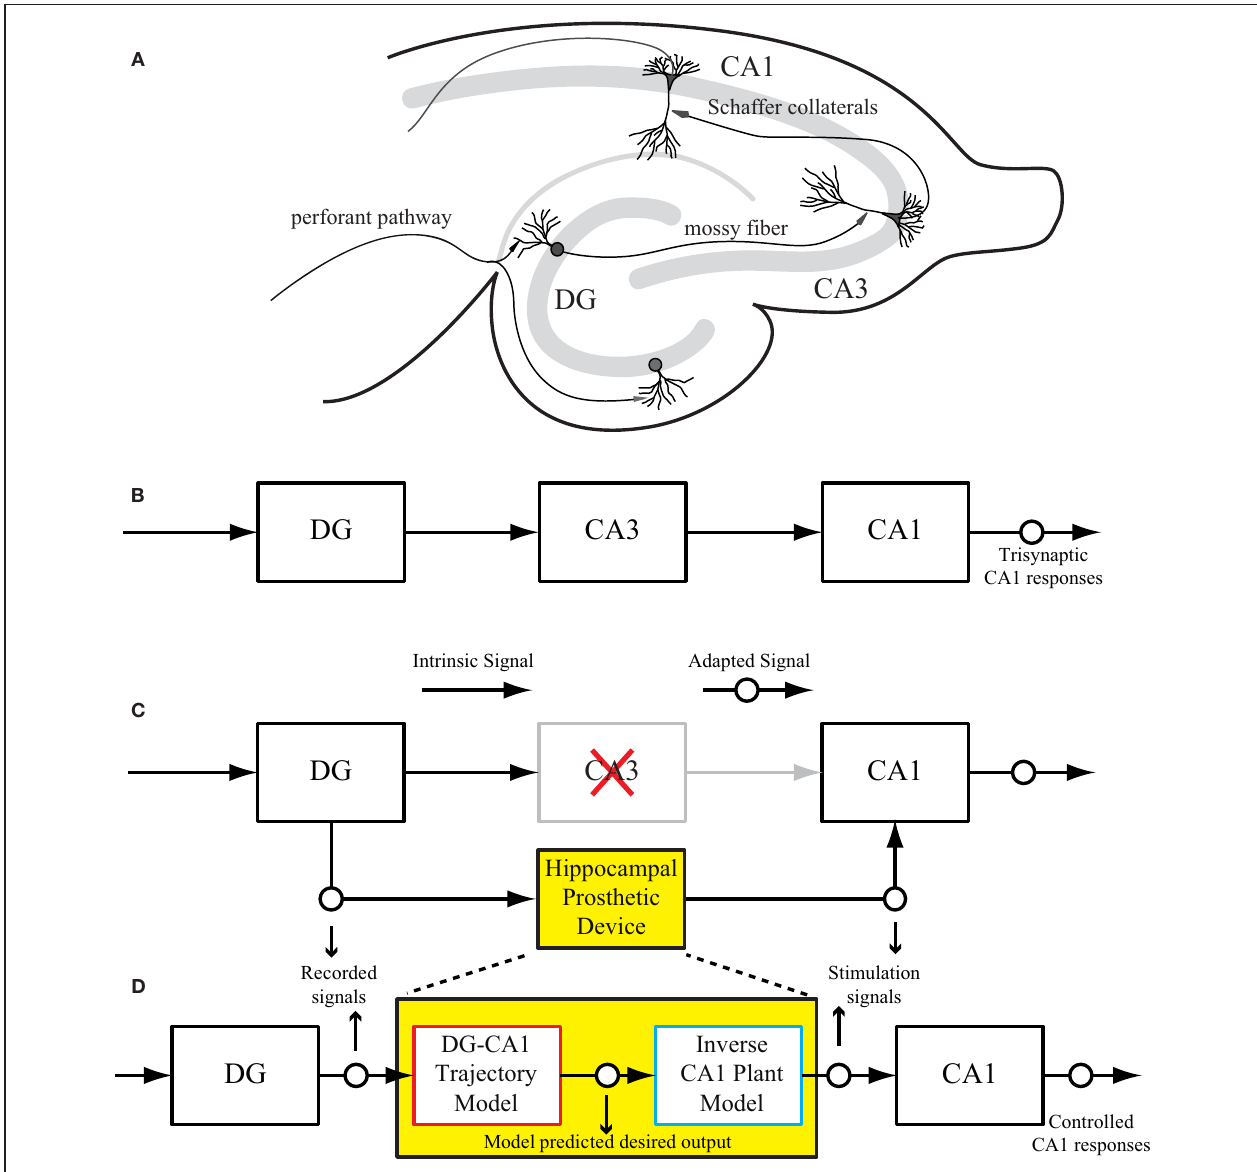
Figure 1A . This trisynaptic circuit can be maintained in a trans- verse slice preparation (Andersen et al., 1969, 2000; Amaral and Witter, 1989). The signal transformations in all three regions